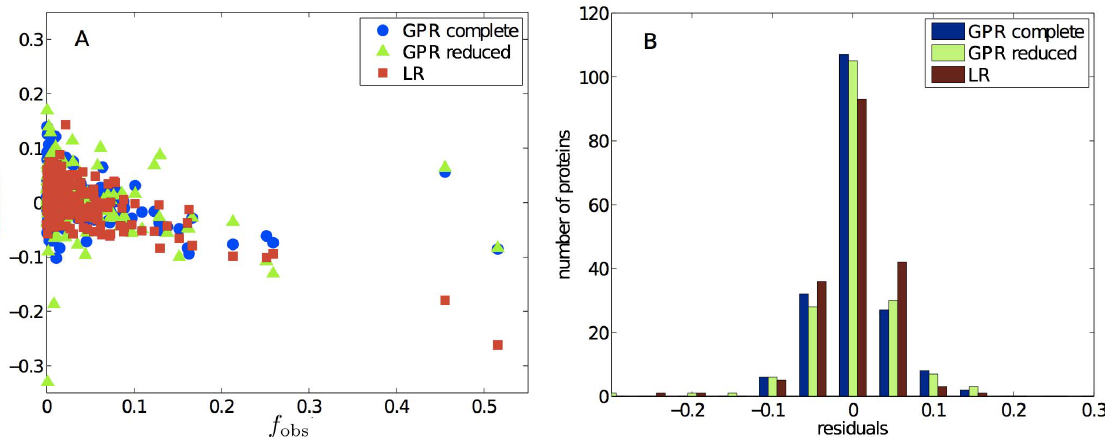
Figure 5. A: Scatter plot of the regression residuals as a function of the observed output function f obs for the complete GPR model (blue circles), the reduced GPR model with only residue categories as variables (green triangles), and the standard LR model (red squares). B: Histogram of the residuals in A that quantifies the quality of the GPR fits.